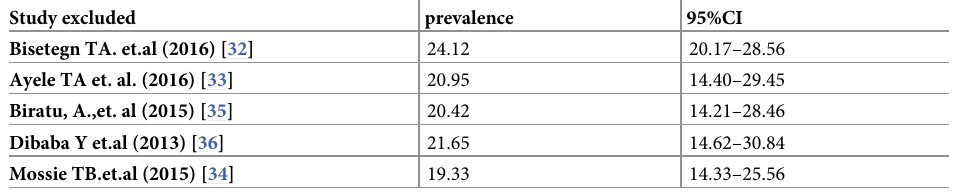
Table 3. Sensitivity analysis of prevalence for each study being removed at a time: Prevalence and 95% confidence interval of antenatal depression in Ethiopia.